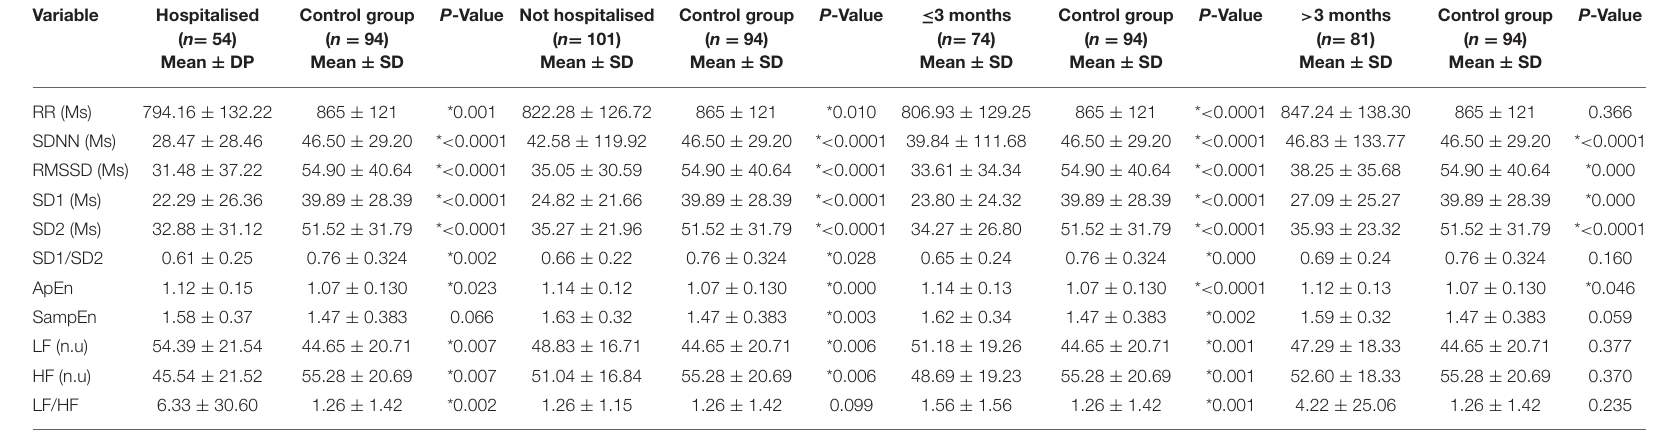
TABLE 4 | Analysis of HRV duration of long COVID and dyspnoea in the hospitalization groups based on the control group. Variable